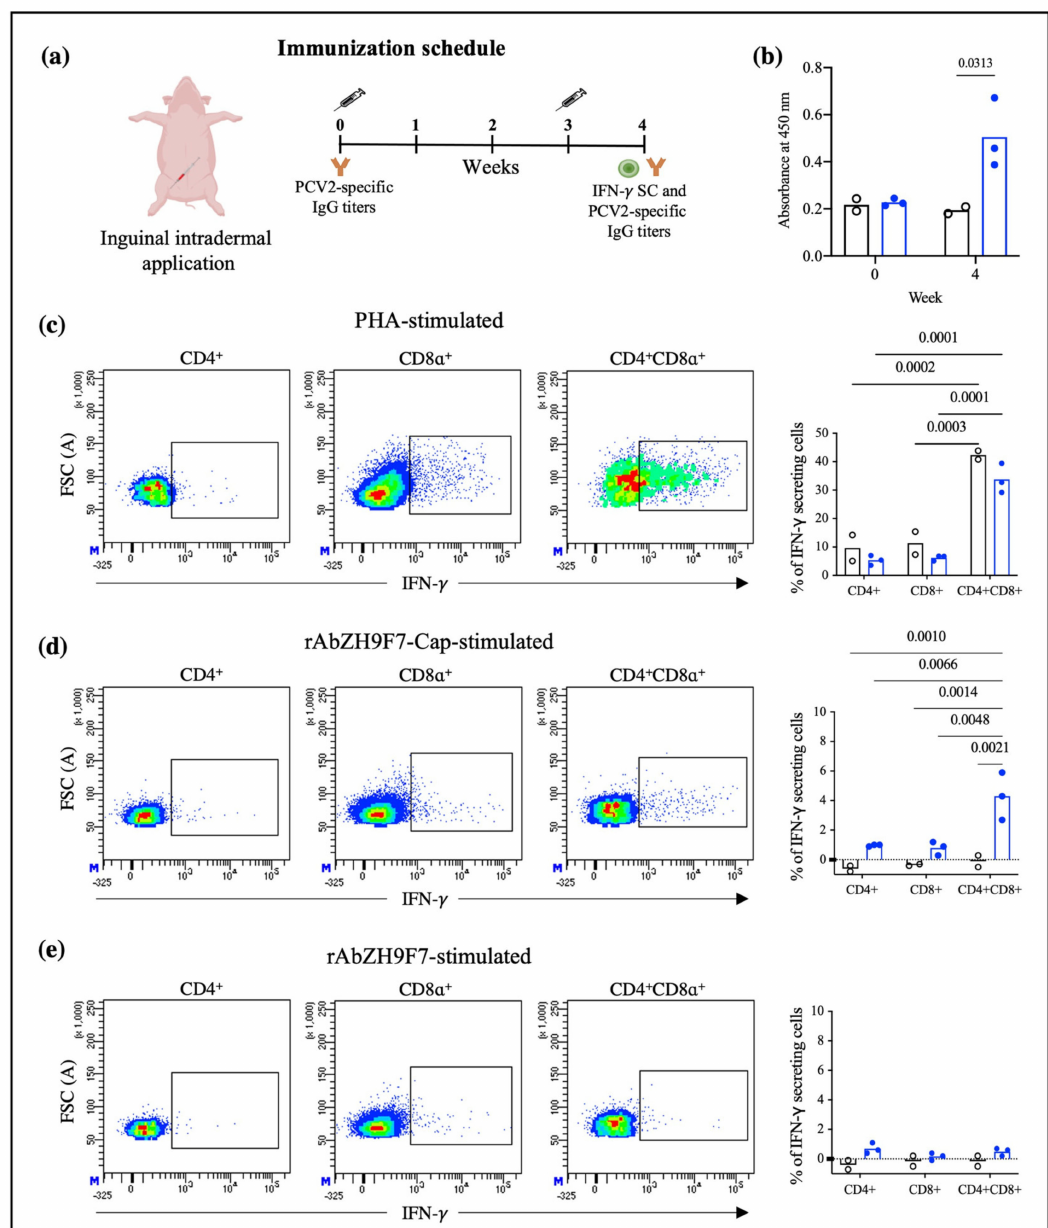
antibodies were detected in the targeted group compared to the control group ( p < 0.05).